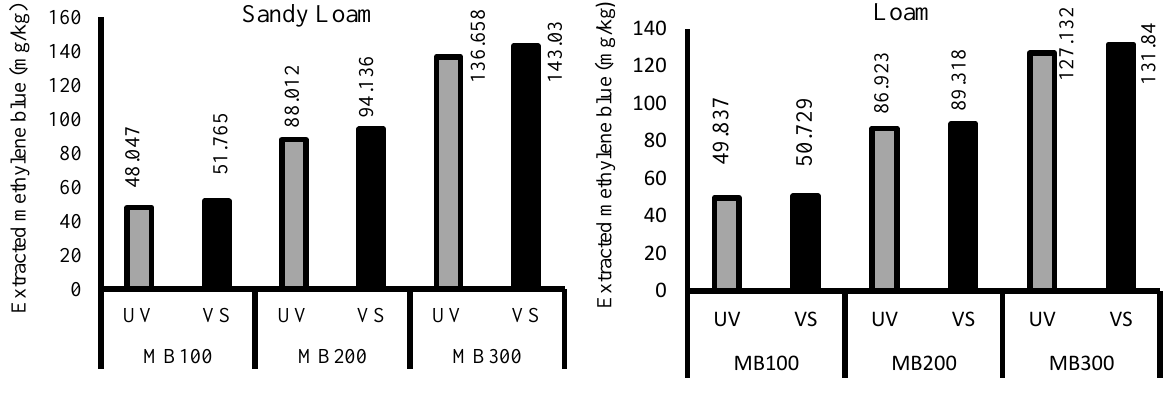
Fig. 6. Effect of MB contamination levels and radiation sources on extracted MB from SL and L soils (each column with mean of 21 samples; different letters indicate significant differences in means of different treatments;